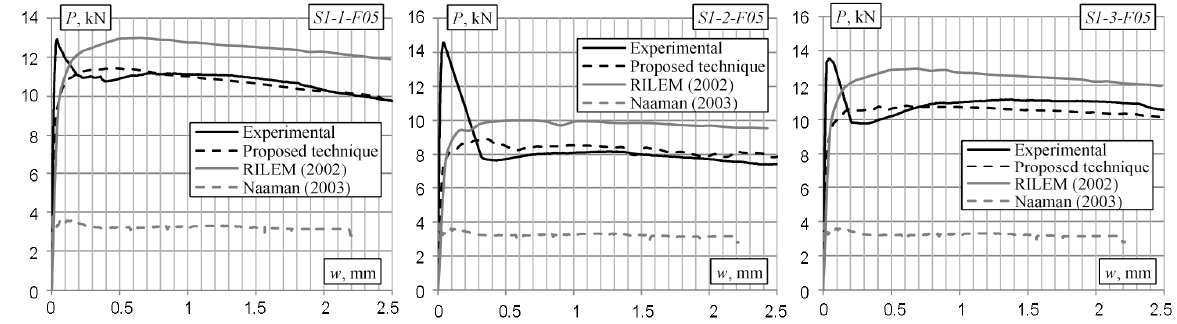
Fig. 9. Comparison of experimental and calculated P-w curves for the experimental beams with 0.5% volume of fibres